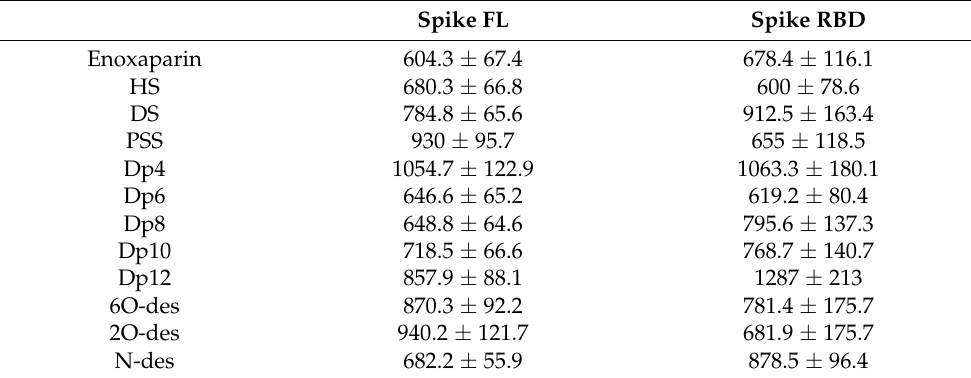
Table 1. Kd values (nM) for Spike FL and Spike RBD to different GAG